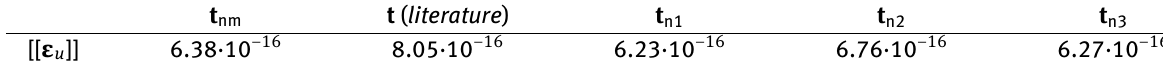
Table 10: Norm of the unbalanced residual normalized internal forces vectors of the Octahedral cell